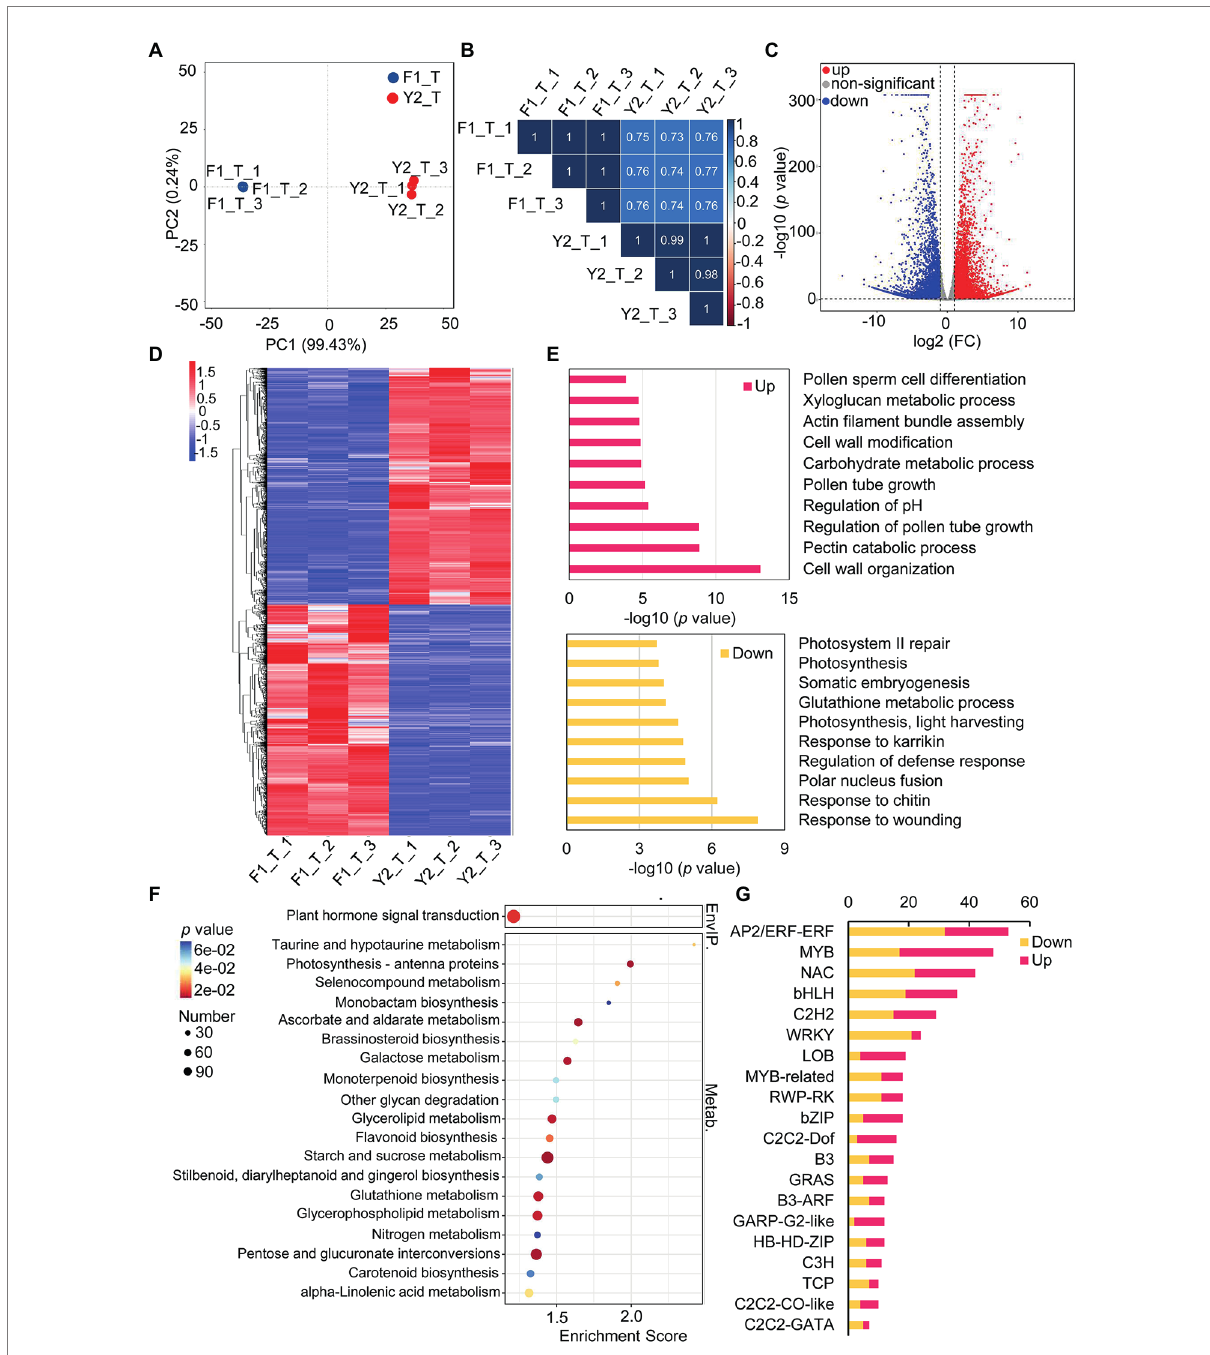
FIGURE 4 Characterization of differentially expressed genes (DEGs) between ‘Yujin2’ and ‘Fengjin1’ LJF samples. (A) PCA of the LJF transcriptome data. (B) Pearson’s correlation analysis of LJF transcriptome data. (C) Volcano plot of the identified DEGs. The increased and decreased DEGs are shown in red and blue, respectively. (D) Hierarchical clustering analysis of DEGs. The columns represent different samples, and the rows represent individual DEGs. The colors in the heat map represent the normalized values of DEGs. DEGs with high or low levels are indicated in red or blue, respectively. Detailed information is provided in Supplementary Table 9. (E) Gene Ontology biological process enrichment of DEGs. Detailed information is presented in Supplementary Table 10. (F) KEGG enrichment of DEGs. Detailed information is provided in Supplementary Table 11. (G) Top 20 differentially expressed transcription factor genes. Detailed information is provided in Supplementary Table